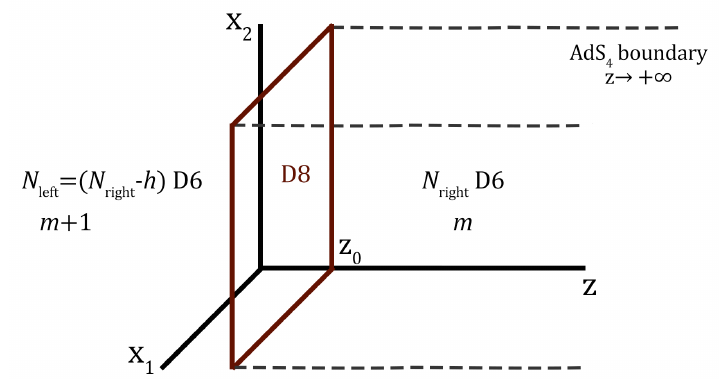
Figure 1 . To cure the Freed-Witten anomaly induced by the H -flux on the D8-brane worldvol- ume, an excess of | h | space-time filling D6-branes must be attached from its position to the AdS 4 boundary. We take m, h > 0 in the